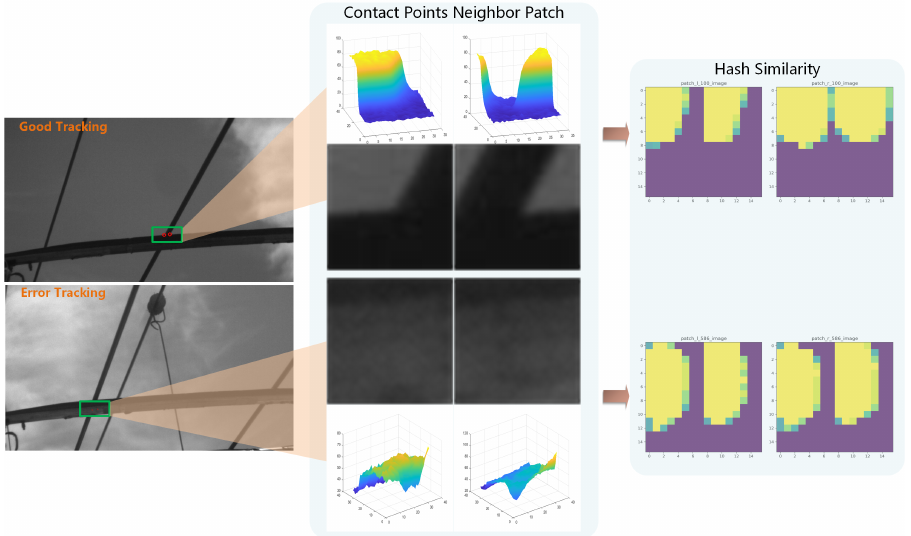
Figure 3. Hash similarity for fault